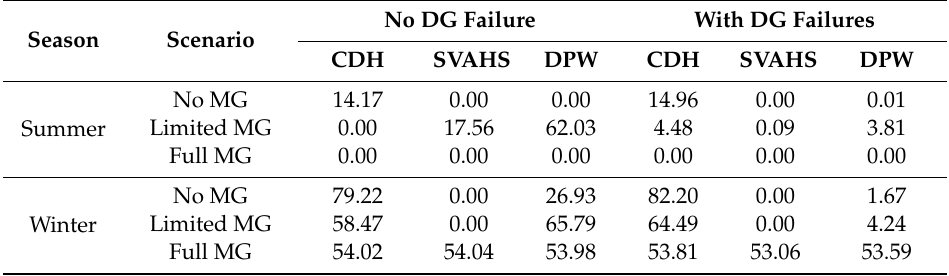
Table 17. Mean survival rates of the system without CDH PV in 14 days outages.